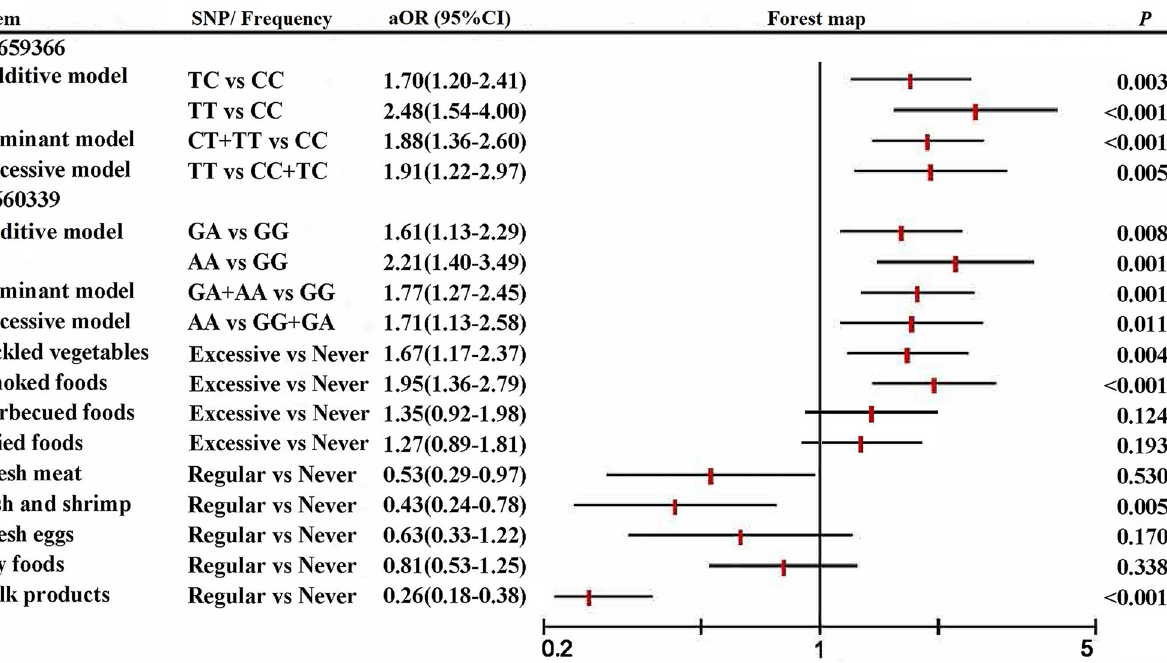
Figure 1. The association of the UCP2 gene and dietary factors with CHDs in multivariate